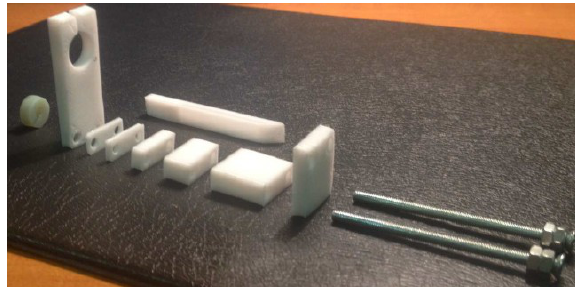
Figure 3. Flexibility measuring device.